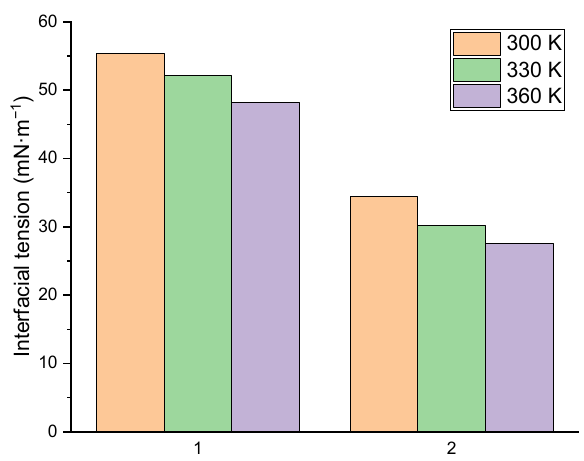
Figure 9. ( 1 ) Change in interfacial tension without and ( 2 ) with the addition of NGOs.